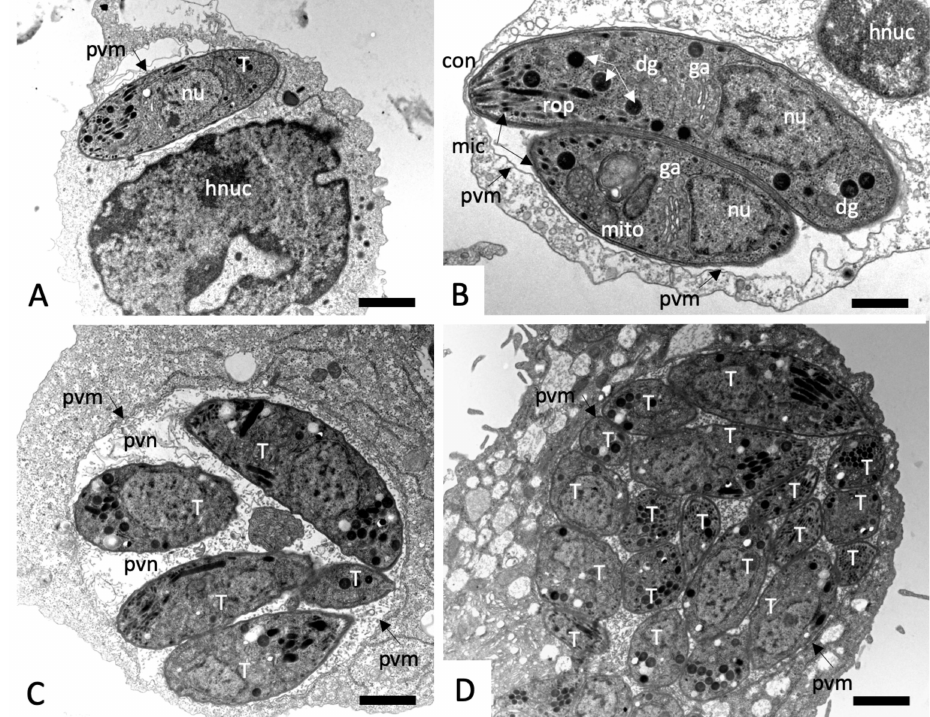
Figure 4. Transmission electron micrographs (TEM) of N. caninum tachyzoite-infected HFF fixed and processed at di ff erent timepoints ( A ) = 8 h; ( B ) = 14 h; ( C ) = 26 h; ( D ) = 50 h post-infection. con = conoid, dg = dense granules, ga = golgi apparatus, hnuc = host cell nucleus, mic = micronemes, mito = mitochondrion, nu = nucleus, pvm = parasitophorous vacuole membrane, pvn = parasitophorous vacuole network, rop = rhoptries, T = tachyzoites. The bar in ( A ) = 0.8; ( B ) = 0.6 µ m; ( C , D ) = 0.8 µ